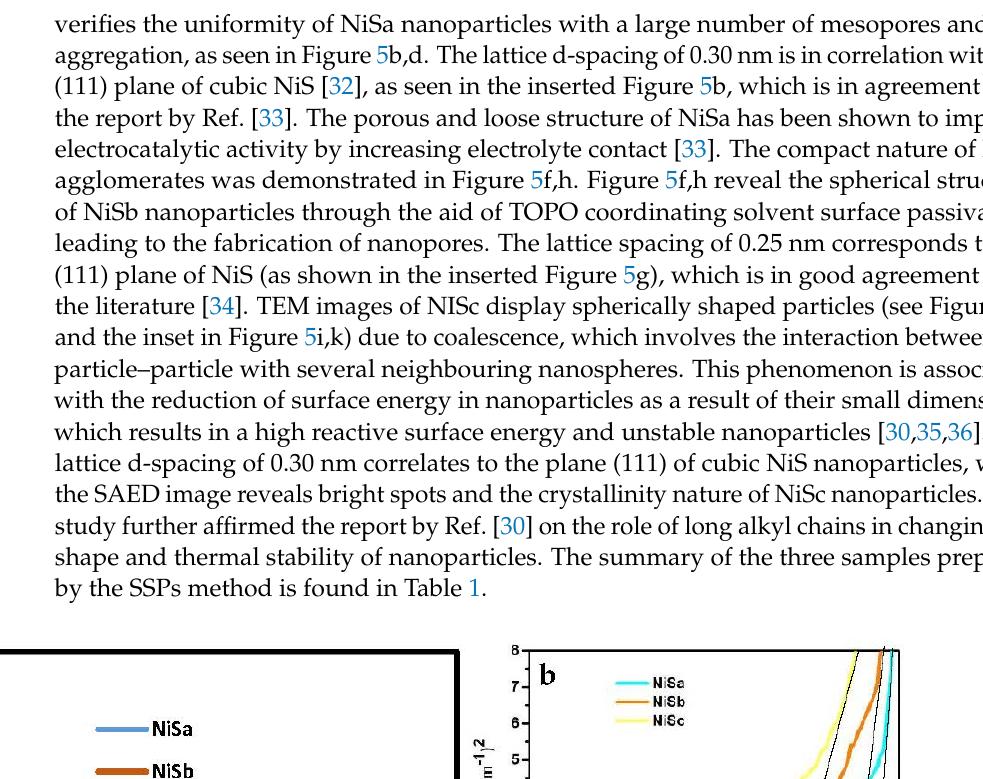
Figure 3. UV—Vis ( a ) and Tauc plot ( b ) spectra for NiSa, NiSb, and NiSc nanoparticles.